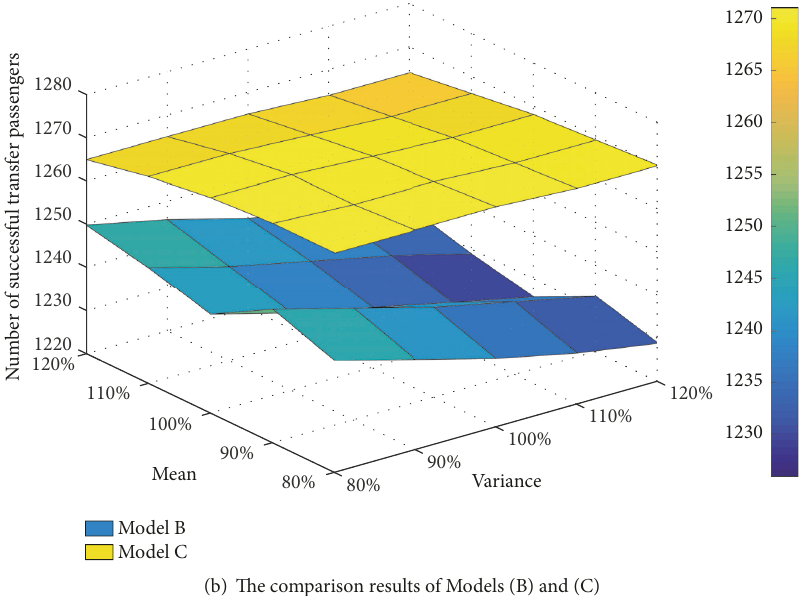
Figure 7: Sensitivity results of ASTP with different means and